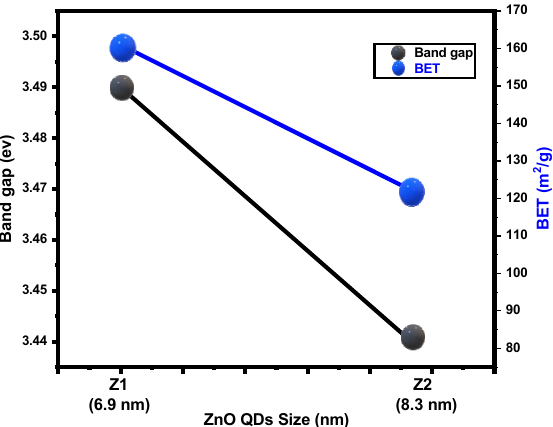
Figure 4. Correlation between BET, Eg, and particle size of ZQDs. As a result of the surface area increase, the mass transfer accelerated and produced further reaction sites, which will increase the reaction catalytic efficiency for Z1 samples compared to the other sample